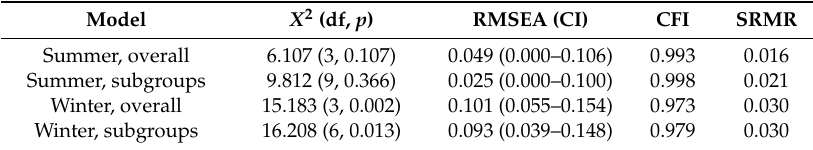
Table 4. Model fit statistics for path analyses 1 .